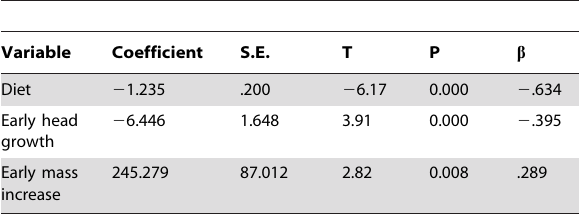
Table 4. Effects of early growth variables on number of bouts taken to perform the associative learning task.